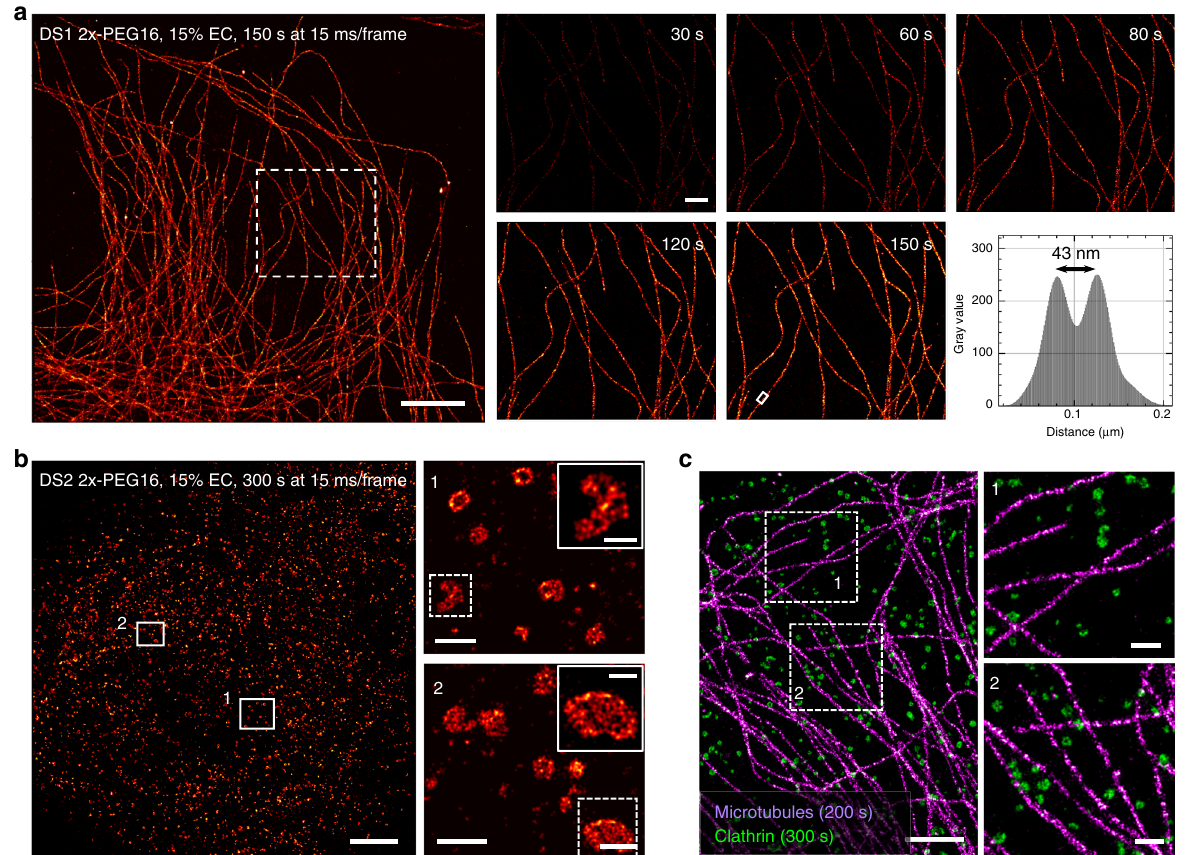
Fig. 3 Fast superresolution imaging with DNA-PAINT-ERS using multiple DS-IS pairs. a DNA-PAINT-ERS imaging of microtubules in U2OS cells using the DS1-2x-PEG16 construct paired with IS1-CF660R. Left panel shows the reconstructed superresolution image of the whole FOV, with zoom-in-views at different acquisition times shown on the right. Bottom right plot shows the intensity pro fi le of the structure in the boxed area in the reconstructed image at 150 s. Similar results were obtained from at least six FOVs in two independent experiments. b DNA-PAINT-ERS imaging of clathrin in U2OS cells using the DS2-2x-PEG16 construct paired with IS2-CF660R. Left panel shows the reconstructed image of the whole FOV, and the right panels are the zoom-in views of the boxed areas in the image on the left. Insets in the two images on the right are the zoom-in views of the regions in the dashed boxes. Similar results were obtained from at least four FOVs in two independent experiments. c Two-color imaging of microtubules (purple) and clathrin (green) in U2OS cells with DNA-PAINT-ERS, using the same DS1-IS1 (tubulin) and DS2-IS2 (clathrin) constructs as used in ( a ) and ( b ). The left panel shows a ~10 × 15 µ m 2 FOV, and the right panels are the zoom-in views of the two regions in the dashed boxes. Similar results were obtained from six FOVs in two independent experiments. Scale bars: 5 µ m ( a , left), 500 nm ( a , right), 5 µ m ( b , left), 500 nm ( b , right), 200 nm ( b , right insets), 2 µ m ( c , left), and 500 nm ( c ,